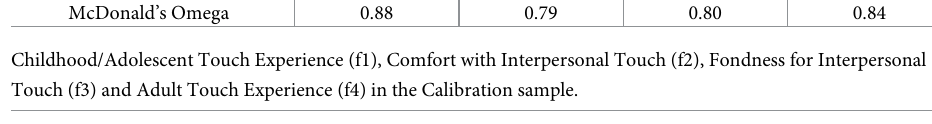
Touch (f3) and Adult Touch Experience (f4) in the Calibration sample.